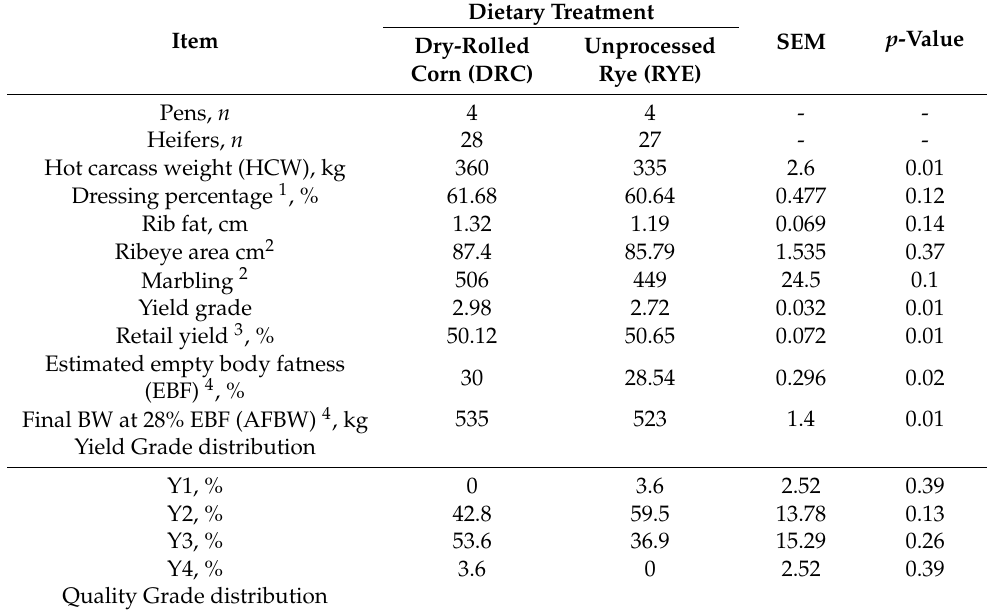
Table 3. Carcass trait